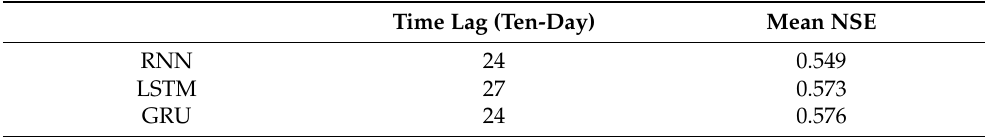
Figure 8. NSE value of ( a ) RNN, ( b ) LSTM, and ( c ) GRU with different time lags (3, 6, 9, 12, 15, 18, 21, 24, 27, and 30 ten days) at ten-day prediction. Table 5. The optimal time-lag settings at ten-day prediction.